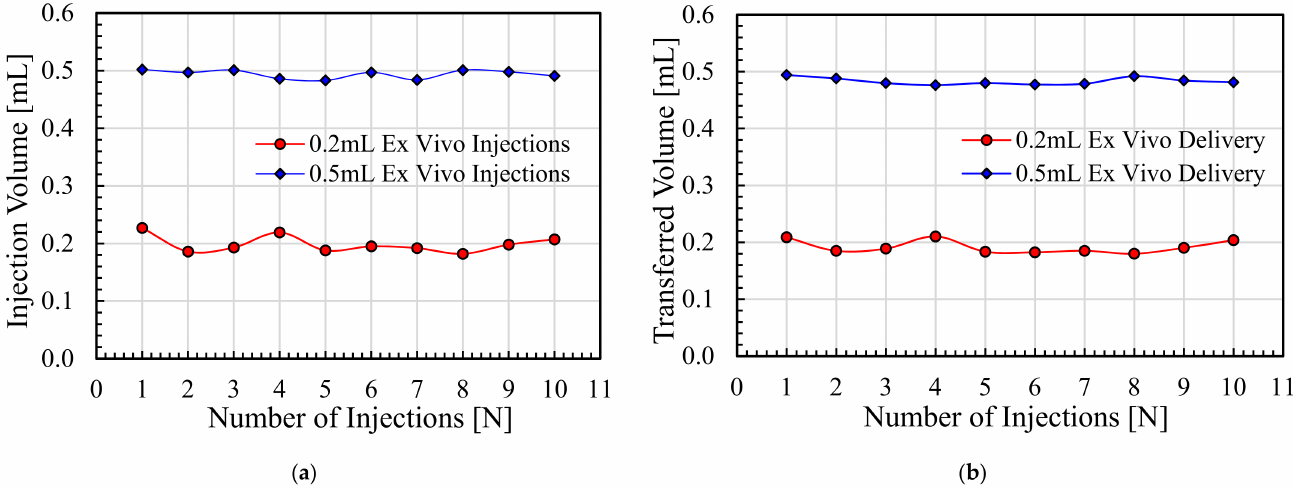
Figure 15. Ex vivo experiments for vaccine delivery by the NFJIS into a porcine tissue specimen. ( a ) Pharmaceutic volume ejected by NFJIS at 0.2 mL/shot and 0.5 mL/shot, and ( b ) vaccine volume transferred into the porcine tissue by the NFJIS for variable-volume